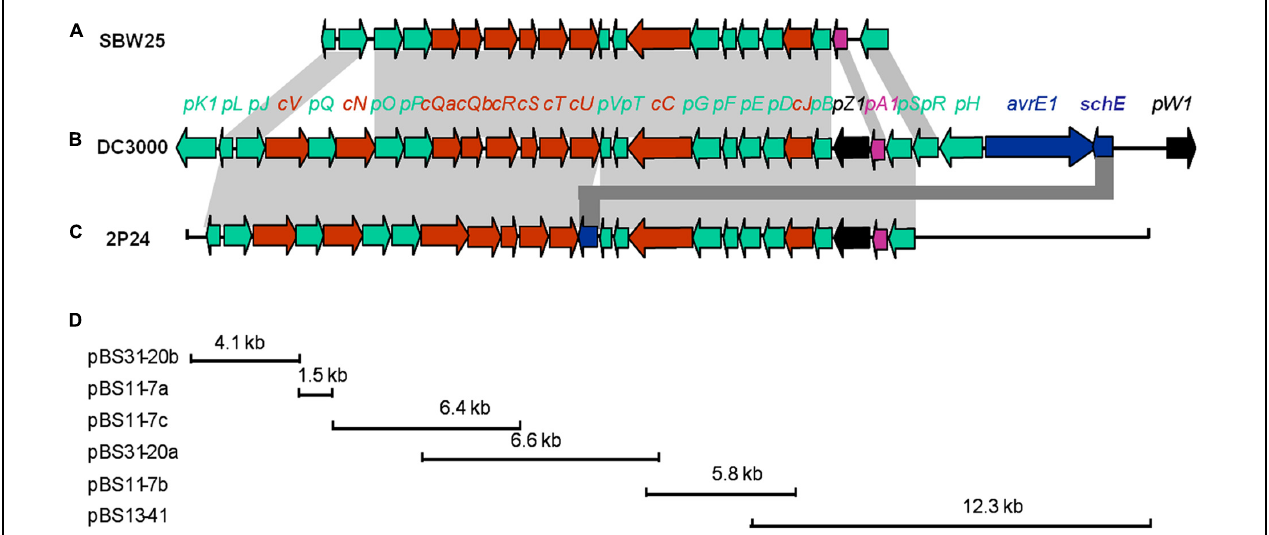
FIGURE 1 | Genetic organization of the rsp/rsc gene cluster of P. fluorescens 2P24 (C) and comparison with the hrp/hrc gene clusters of P. fluorescens SBW25 (A) and P. syringae pv. tomato DC3000 (B) . Predicted open reading frames and their orientation are shown by large arrows. Conserved rsc/hrc genes are shown as red arrows, conserved rsp/hrp genes as green arrows, and harpin proteins as black arrows. Additional ORFs are shown as blue arrows. Homologous genes are connected with gray shading. Full gene names within rsc/rsp and hrc/hrp clusters were shortened and are indicated by a single letter preceded by “ c ” or “ p ”. (D) The cloning procedures and subclones contain rsp/rsc gene fragments. For details, see Tables 1 and 2 .